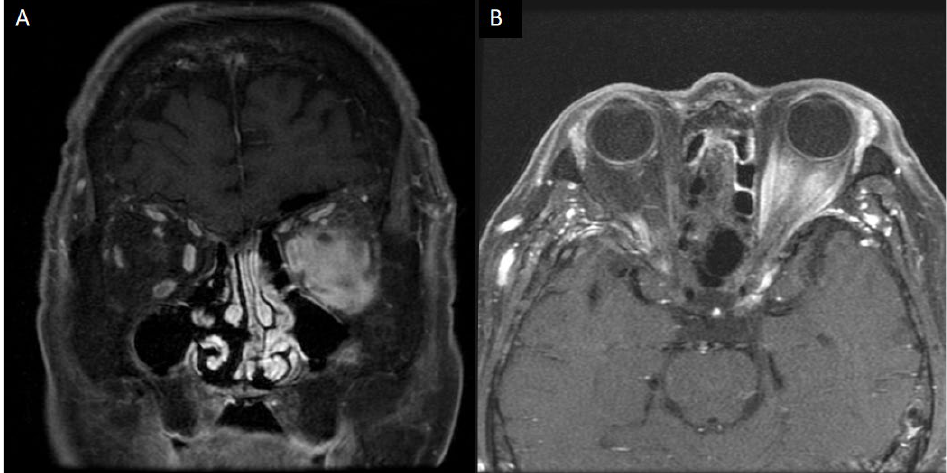
Figure 3. After treatment, the orbital MRI revealed a remarkable resolution of inflammation ( A , B